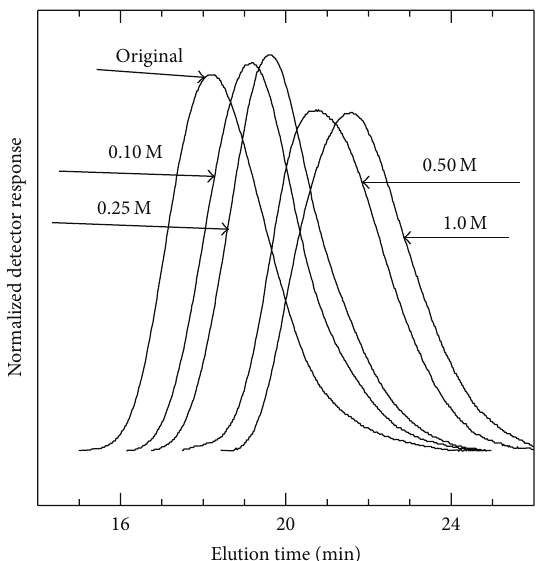
Figure6:Sizeexclusionchromatogramsoftheoriginalchitosanand the fragments resulting from hydrolysis of 1.0% (w/v) chitosan with different HCl concentrations at 65 ∘ C for 5h.